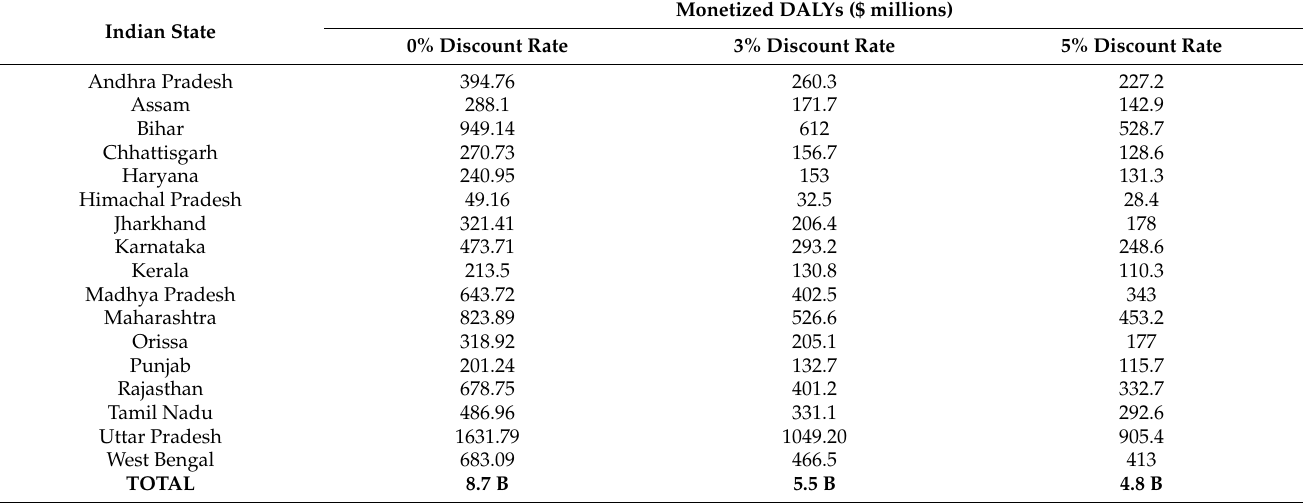
Table A3. Sensitivity analysis: monetized DALYs at 0%, 3%, and 5% discount rates: 17 Indian